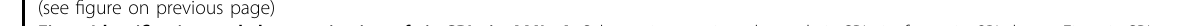
Fig. 1 Identi fi cation and characterization of circSPI1 in AML. A . Schematic overview showed circSPI1 isoforms in SPI1 locus. Five circSPI1s were retrieved from the circRNA compendium MiOncoCirc database. BSJ back-splicing junction. B CircSPI1s were hematopoietic lineage-speci fi c circRNAs. The expression of fi ve circSPI1 isoforms was analyzed in diverse cancer types from MiOncoCirc database. AML acute myeloid leukemia, CML chronic myeloid leukemia, ALL acute lymphocytic leukemia, CLL chronic lymphocytic leukemia, MPN myeloproliferative neoplasm, MM multiple myeloma, STAD stomach adenocarcinoma, SKCM skin cutaneous melanoma, SECR secretory cancer, SARC sarcoma, PRAD prostate adenocarcinoma, PAAD pancreatic adenocarcinoma, OV ovarian serous cystadenocarcinoma, MISC miscellaneous cancer, LUNG lung adenocarcinoma, HNSC head and neck squamous cell carcinoma, GBM glioblastoma multiforme, COLO colon adenocarcinoma, BRCA breast invasive carcinoma, BLCA bladder urothelial carcinoma. C The existence of circSPI1s was validated with divergent and convergent primers in THP-1 and NB4 cells. The schematic diagram illustrated the location of divergent and convergent primers and the recognized circSPI1s of divergent primers (left panel), then circSPI1s were detected by RT-PCR (right panels) with divergent and convergent primers before and after treatment with RNase R. Two major bands produced by the divergent primer pair dP23 corresponded to circSPI1-Ex234 (L and S) and circSPI1-Ex23 (L and S), respectively. Two major bands produced by the divergent primer pair dP34 corresponded to circSPI1-Ex234 (L and S) and circSPI1-Ex34. One band produced by dP24 corresponded to circSPI1-Ex234 (L and S). Convergent primers were served as a negative control. dP divergent primers, cP convergent primers. D CircSPI1 isoforms were analyzed by RT-qPCR in THP-1 and NB4 cells. E The junction sites of circSPI1 isoforms were identi fi ed by sanger sequencing. All detected amplicons by divergent primers were subjected to TA clone, and then positive clones were performed sanger sequencing. F The relative expression levels of circSPI1 isoforms were analyzed in THP-1 and NB4 cells. The left two panels: RT-qPCR analysis measured the relative levels of fi ve circSPI1s. The right two panels: